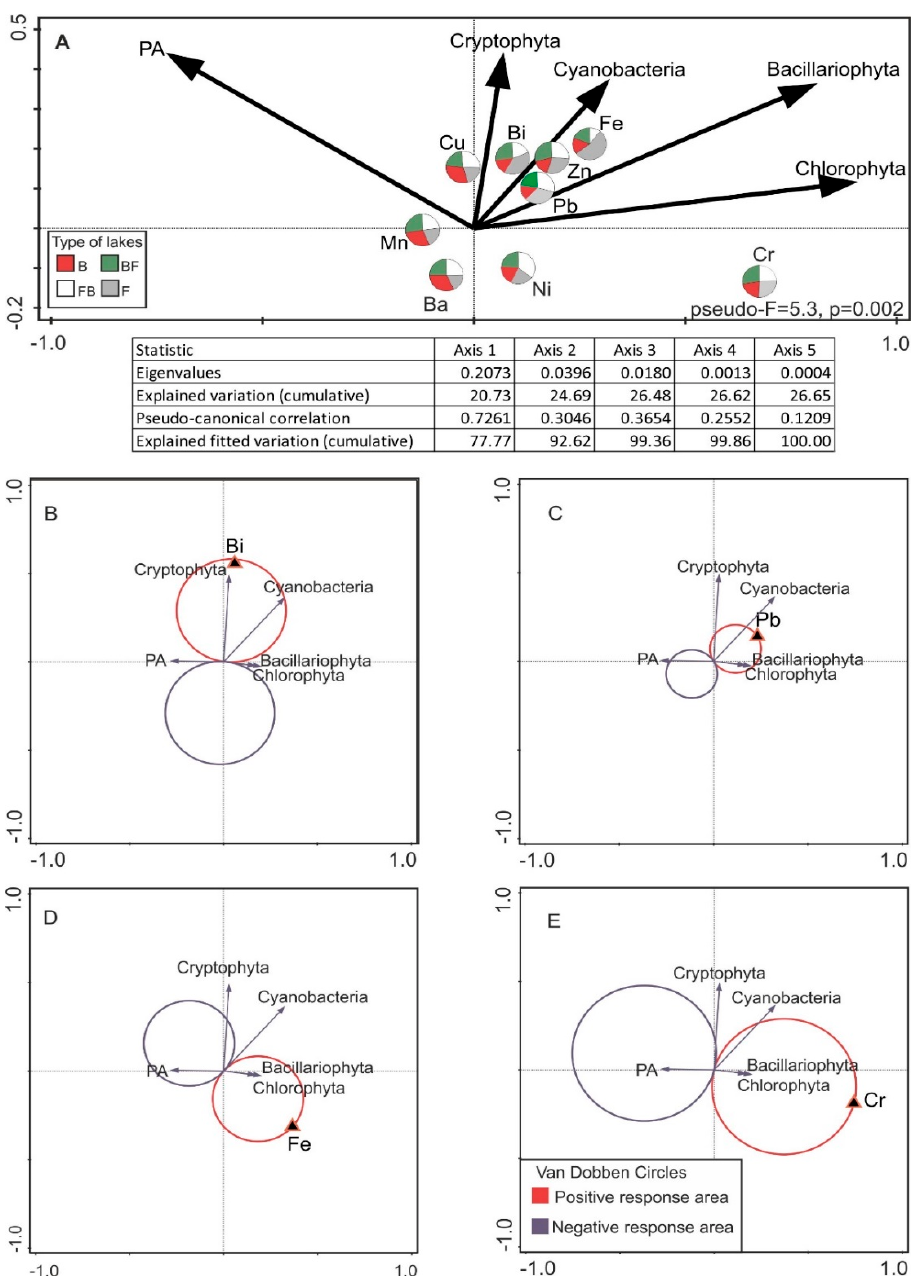
Figure 3. ( A ) A t-value biplot with van Dobben circles based on the redundancy analysis (RDA) of heavy metals in surface water and phytoplankton biomass (RDA, figure not shown); ( B ) the van Dobben circles for Bi; ( C ) the van Dobben circles for Pb; ( D ) the van Dobben circles for Fe; for Cr ( E